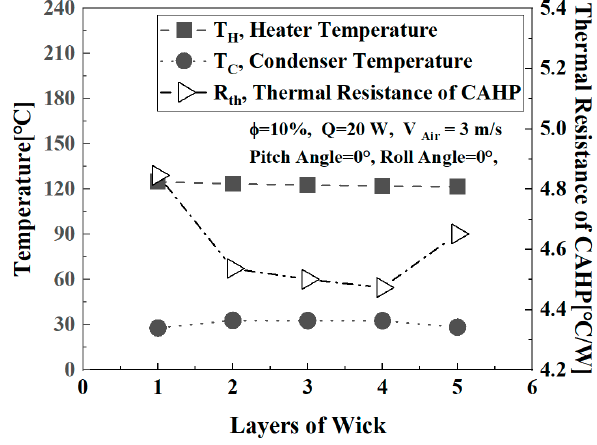
Figure 15. Simulated thermal characteristics of the CAHP according to the layers of the wick ( V air = 3 m/s, Q = 20 W, pitch angle = 0°, and roll angle = 0°).